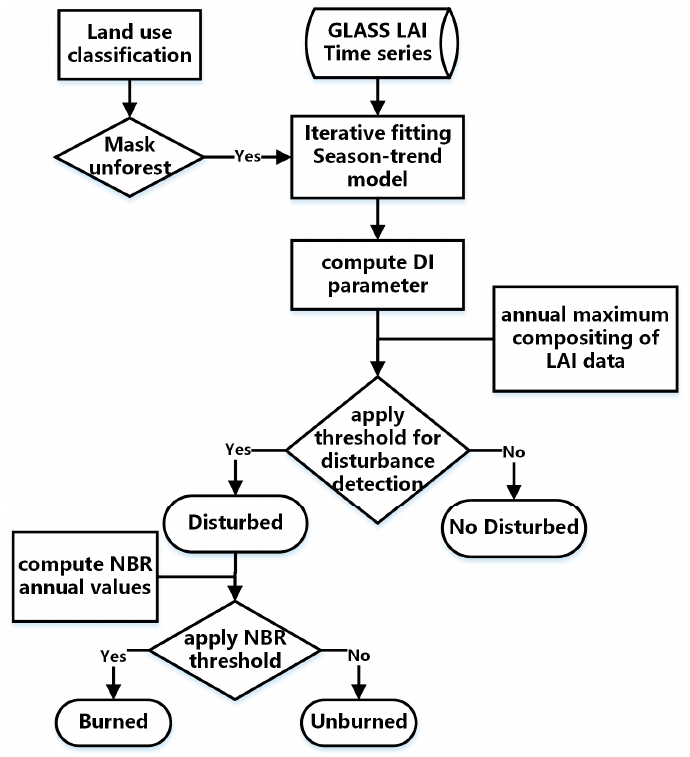
Figure 2. Flow chart of the forest disturbance detection. LAI = leaf area index; DI = disturbance index; NBR = normalized burn ratio.